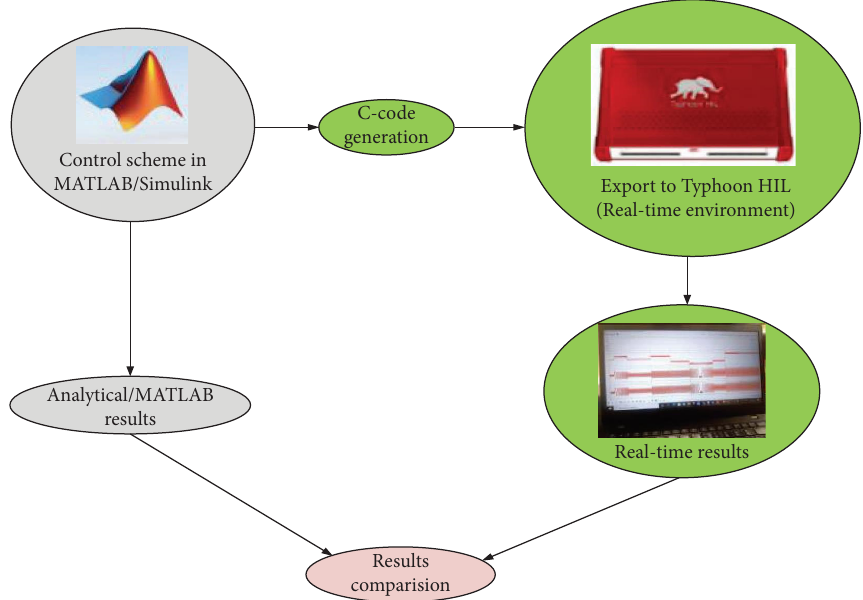
Figure 10: Implementation steps and set-up for real-time